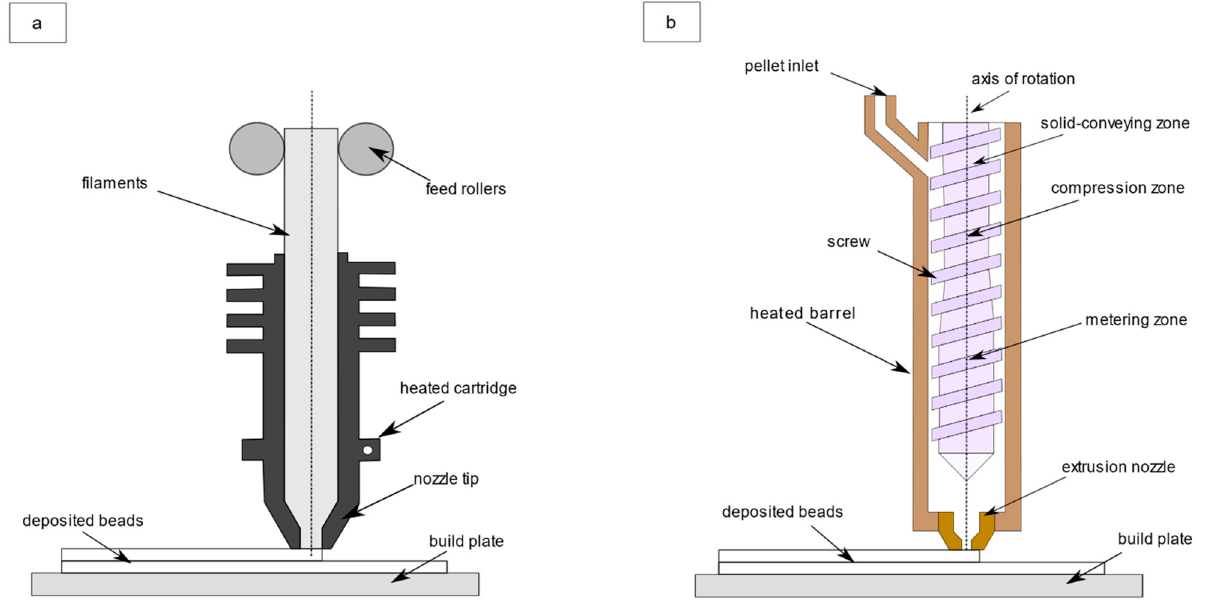
Figure 1. ( a ) Perspective view of FFF process; ( b ) front view of the complete extrusion system in PAM. Because of the load exerted both by the rotating screw and gravity, the pellet drops downstream in PAM extruders screw vanes, following a helical path. The pellet is gradu- ally heated until it reaches the melting point (although there is a softening zone instead of a sharp melting point for amorphous polymers).